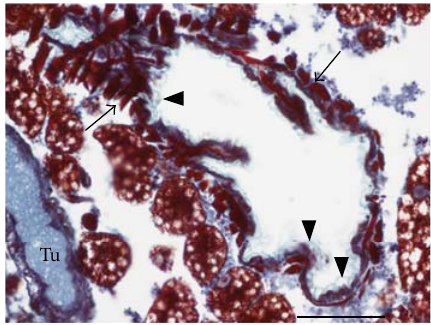
Figure 4: Detail of the musculature (arrows) and cuticle lining (arrowheads) of a diverticular pouch (di ff erent section but same pouch as the one onright in Figure 3) and tubule (Tu) with contents of a second pouch (on left in Figure 3). Scale bar =